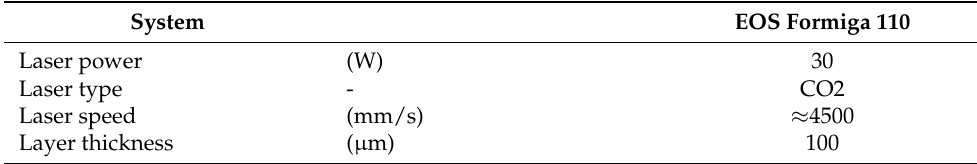
Table 5. Process parameters used for the beads produced by